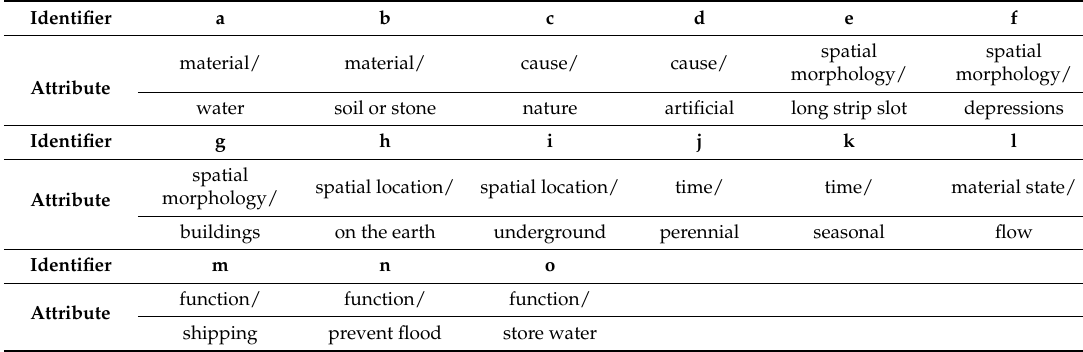
Table 2. Comparison table between attributes and